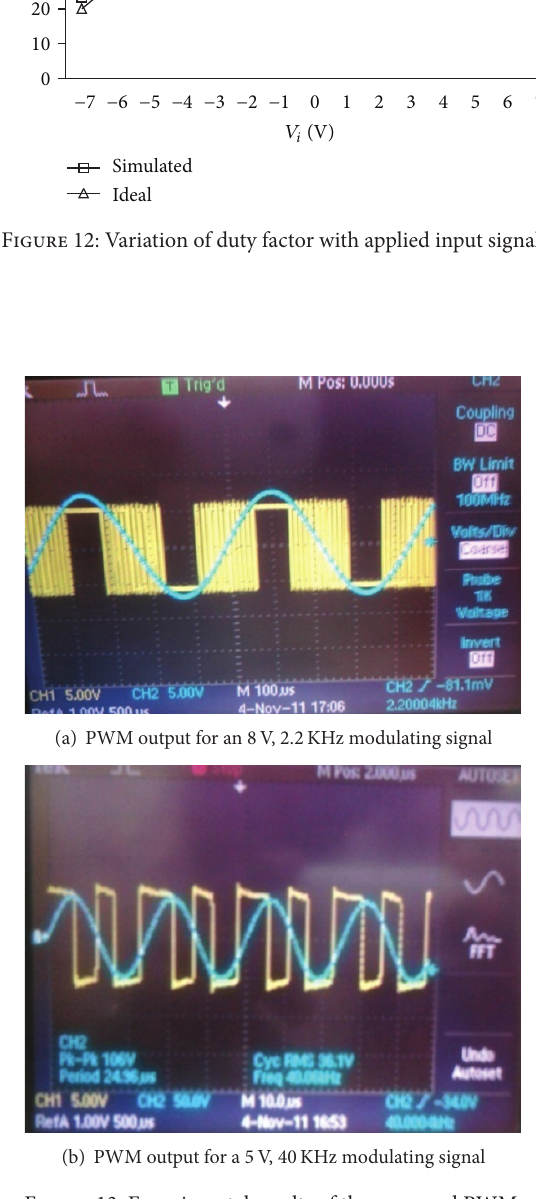
F 13: Experimental results of the proposed